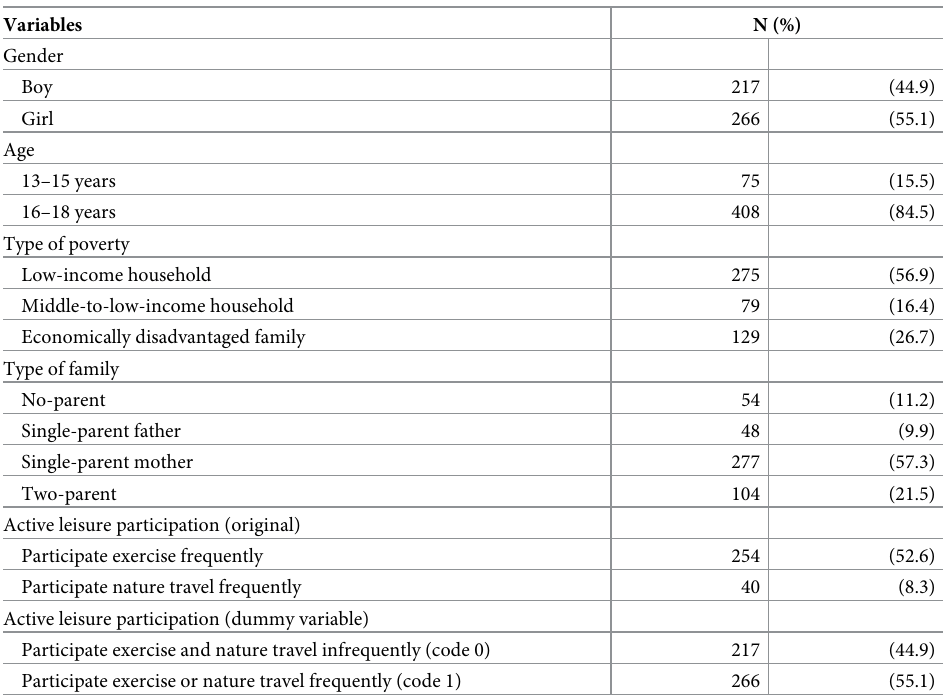
Table 1. Descriptive statistics (N =